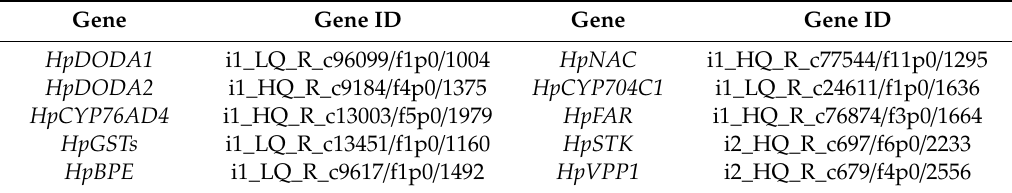
Table 2. The list of 10 DEGs used for